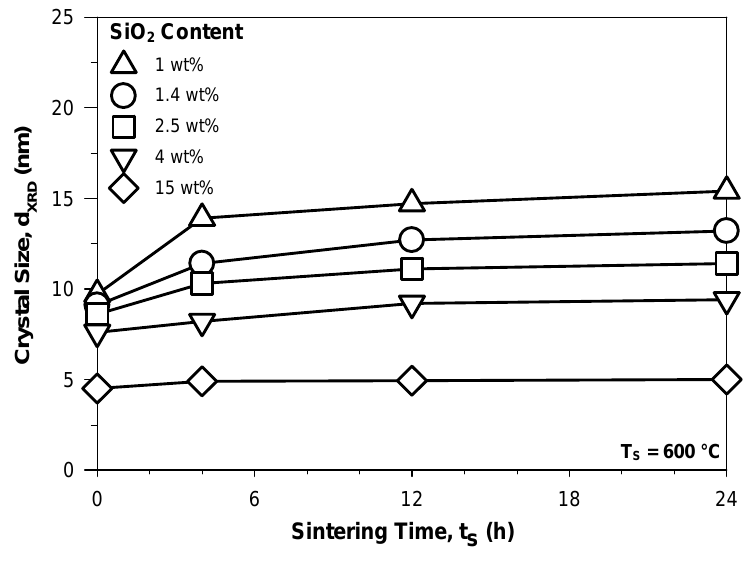
) of the SnO -SiO nanocomposites as a function XRD 2 2 2